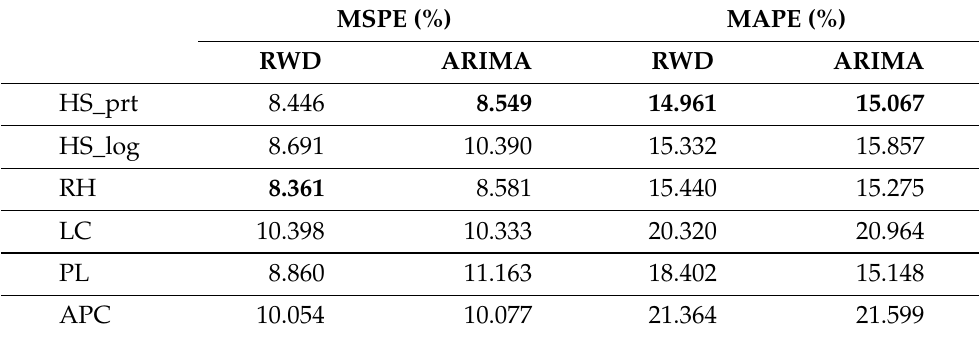
Table 10. Results of the percentage error tests for predicted mortality rates of 10 years out-of-sample for well-known stochastic mortality models against HS_prt for GR